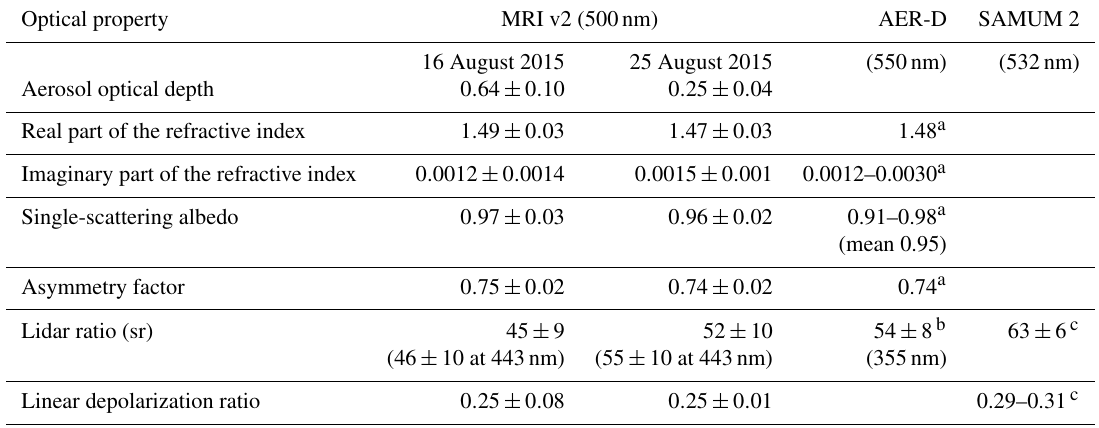
Table 7. Aerosol optical properties of the MRI v2 retrievals using the sky radiometer measurements during SAVEX-D, the aircraft in situ measurements of Saharan dust in six flights during AER-D, and Raman lidar measurements of Saharan dust in 3d during SAMUM